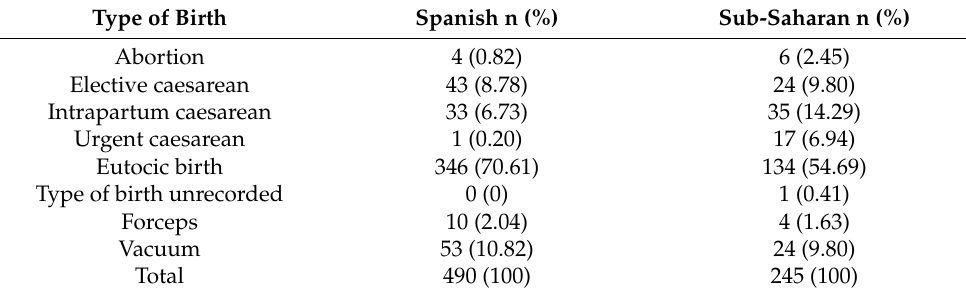
Table 1. The variable type of birth according to origin. Type of